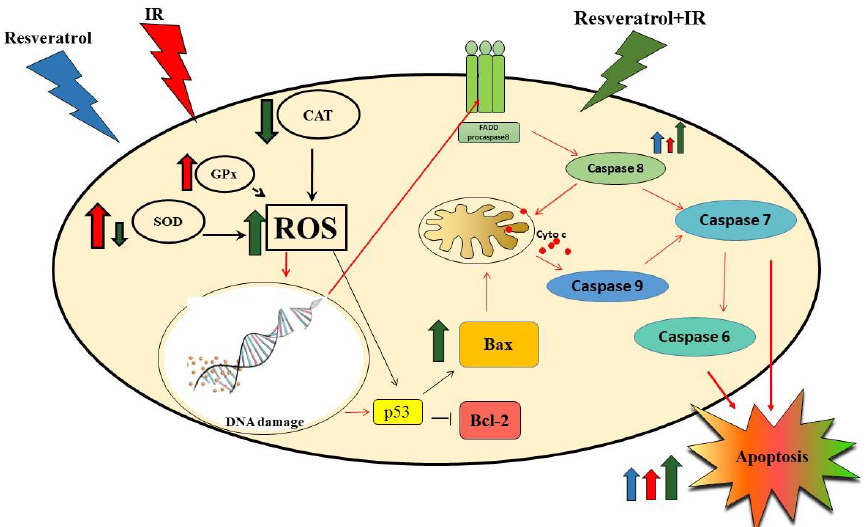
Figure 10. This image shows only the pathways of the resveratrol-induced radiosensitivity mecha- nism in MCF-7 cells that were investigated in this work (black arrows) or discussed on the basis of literature data (red arrows). Resveratrol potentiated the radiosensitivity in MCF-7 cells by decreasing antioxidant enzyme activity (SOD and CAT). Inhibiting SOD and CAT activity would result in increased ROS, thereby causing damage to cellular macromolecules. DNA damage leads to activation of the p53 protein. The p53 protein mainly acts as a transcription factor that induces and/or inhibits the activation of many genes associated with the induction of apoptosis. In the intrinsic pathway of apoptosis, p53 may directly activate the proapoptotic Bax protein or inhibit the antiapoptotic bcl-2 protein. The Bax protein causes the opening of mitochondrial channels and the release of cytochrome c. Cyt c, along with other proapoptotic agents, activates caspase 9, which affects the activation of executive caspases. DNA damage can also induce the extrinsic pathway of apoptosis associated with the activation of surface death receptors (FAS). The changes in the con- formation of these receptors after attaching to the FADD protein lead to the activation of caspase 8, which can induce death via direct cleavage of caspase 7, or can activate intrinsic apoptosis. Thus, resveratrol enhances the process of apoptosis in MCF-7 cells that are exposed to IR. The presented basic research helps to better understand the mechanism of action of resveratrol in breast cancer cells under the conditions of increased oxidative stress. How-